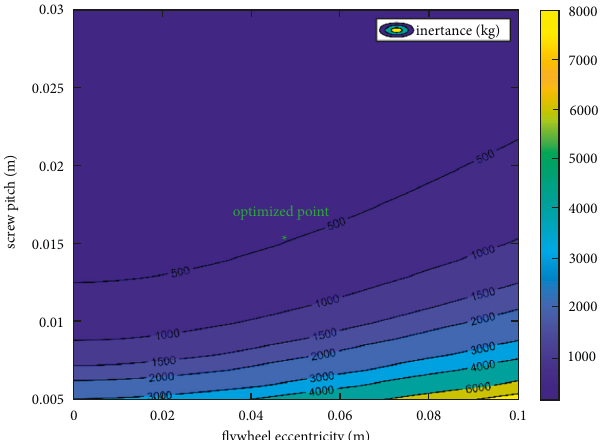
Figure 13: The change of dynamic tire load subject to the change of flywheel and screw pitch in the series model.